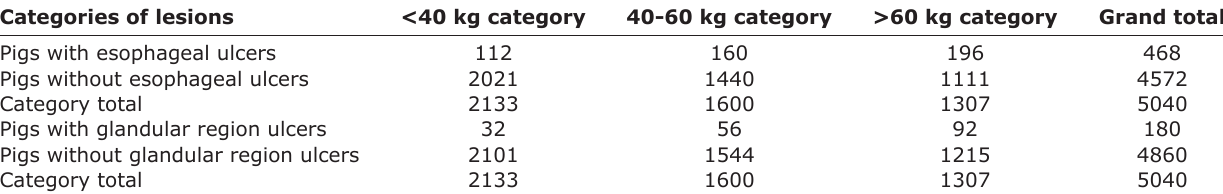
Table-8: Distribution of pig ulcers according to weight